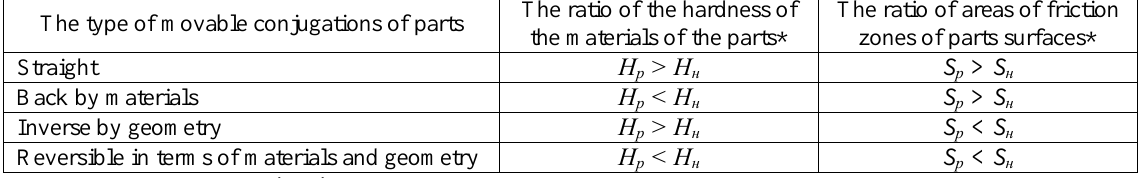
Conditions of existence of direct and reverse TTS and their